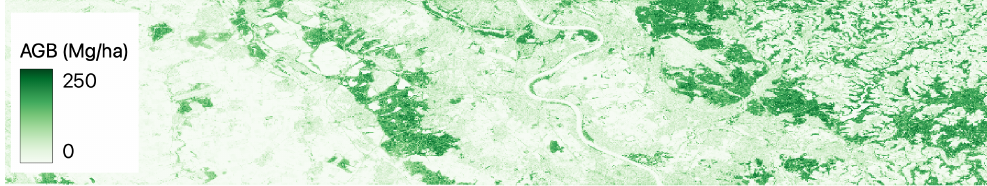
Figure 5. Predictions of AGB using the machine learning approach [10] in Central Europe.